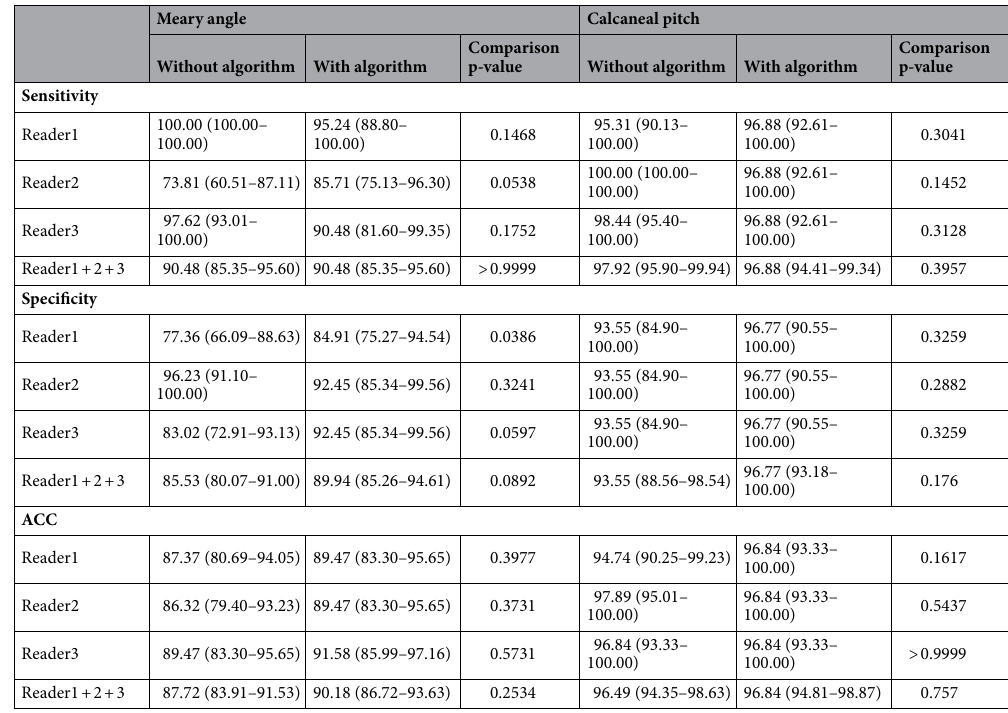
Table 4. The sensitivity and specificity of Meary angle and calcaneal